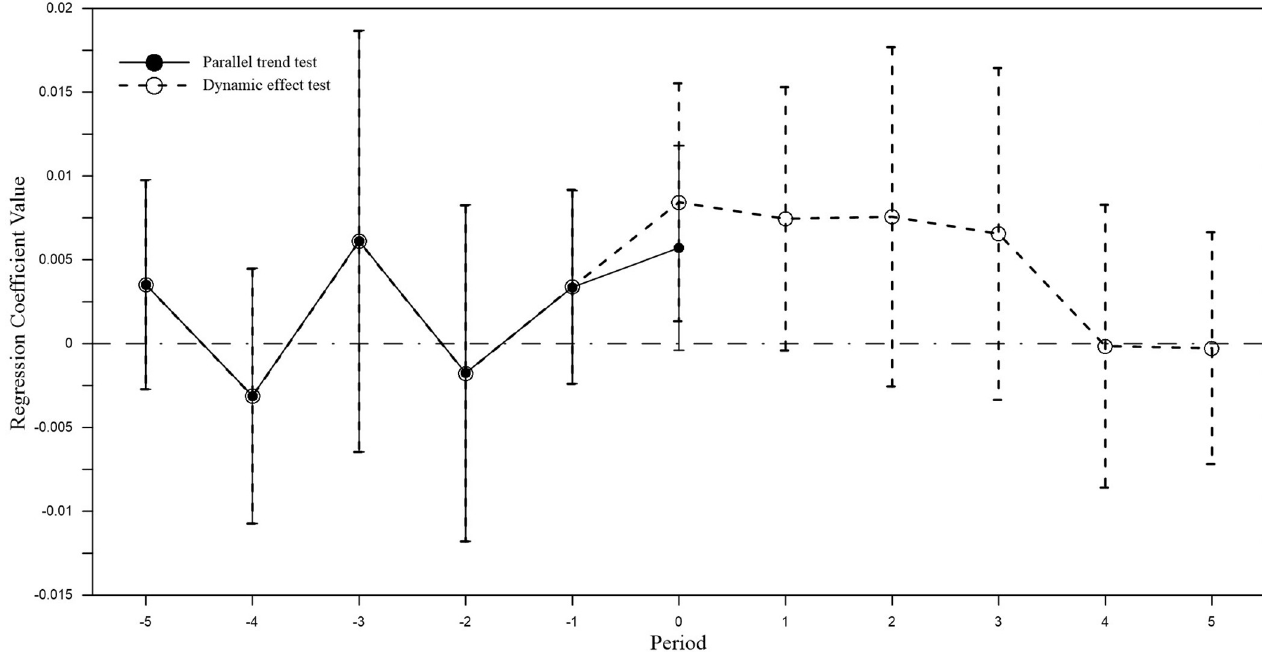
Fig 5. Parallel trend test and dynamic effect